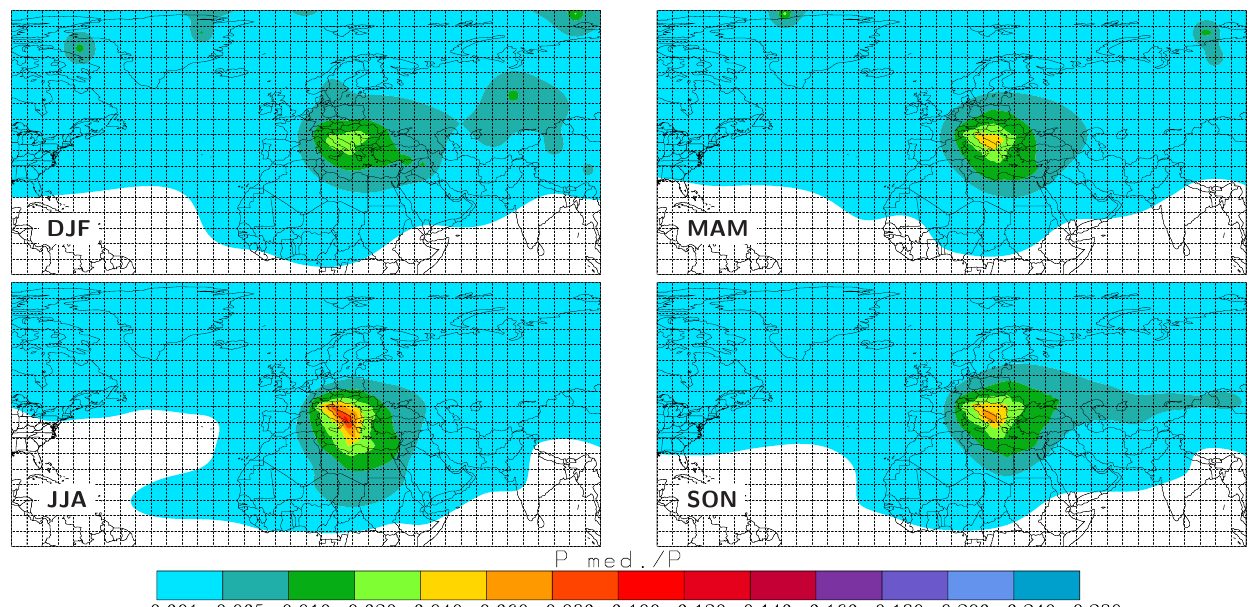
Fig. 15. Same as Fig. 12 (precipitation fraction) but for the Adriatic